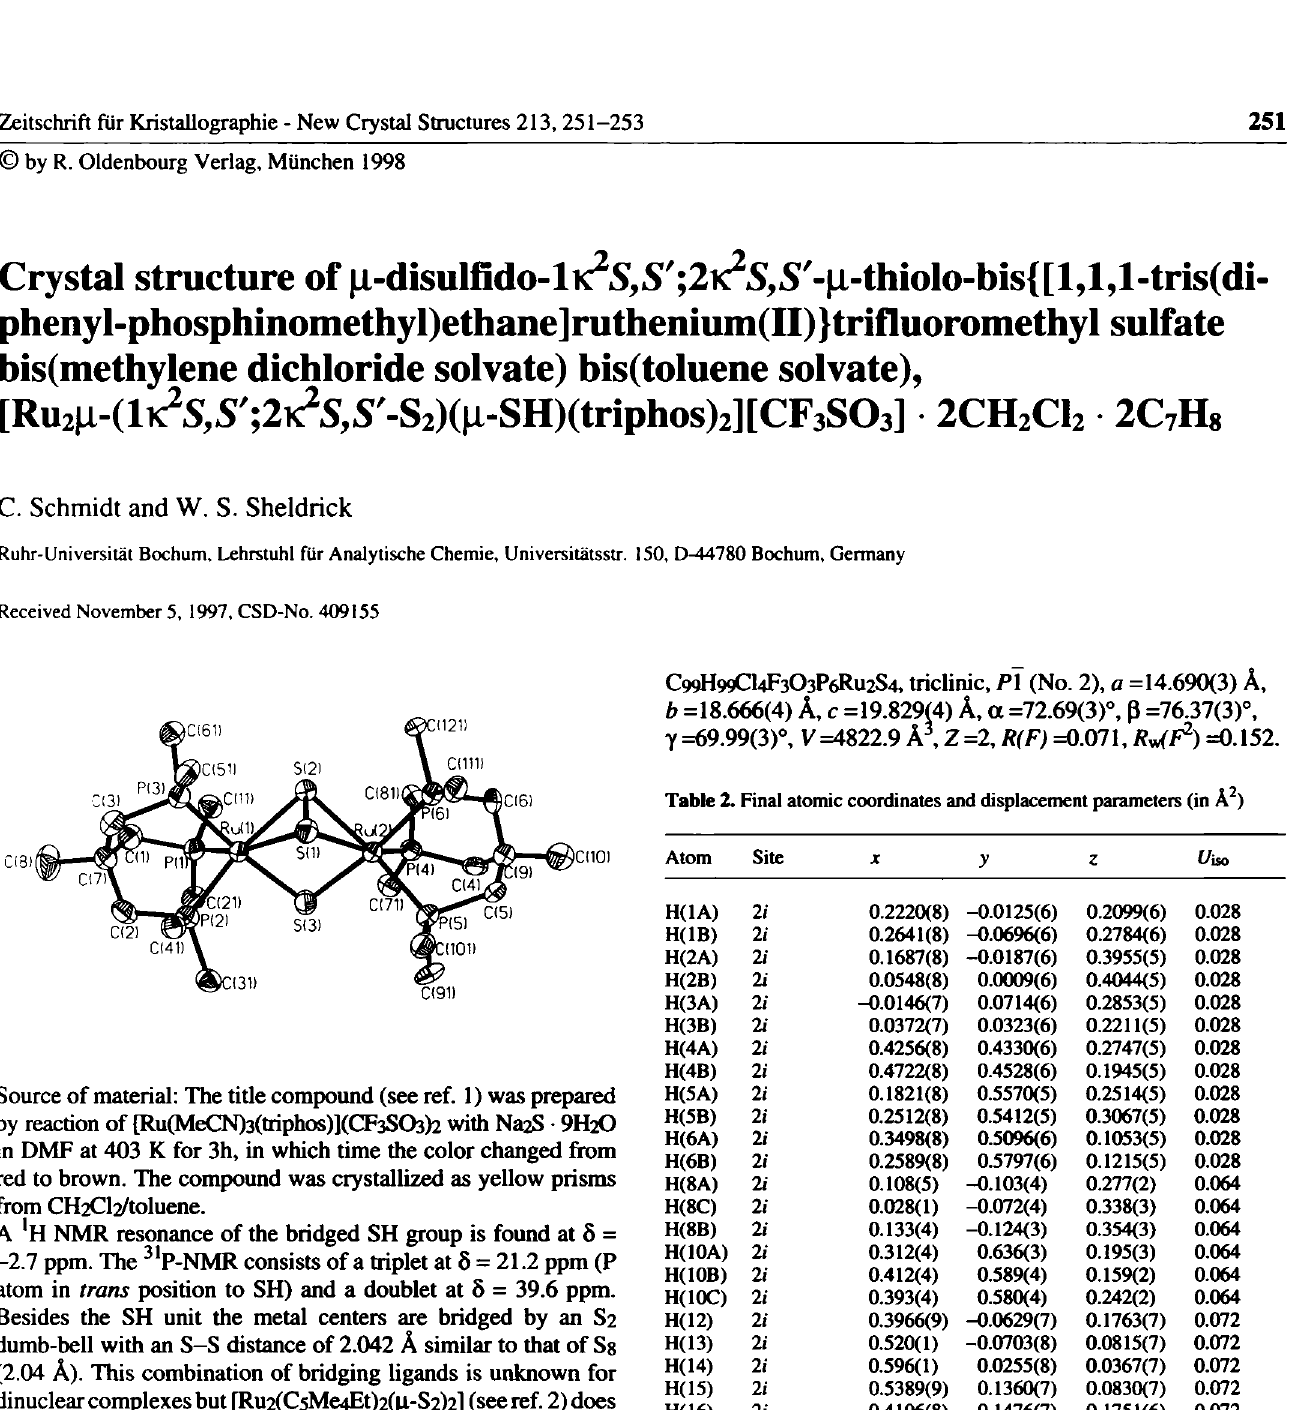
Table 1. Parameters used for the X-ray data collection Crystal: